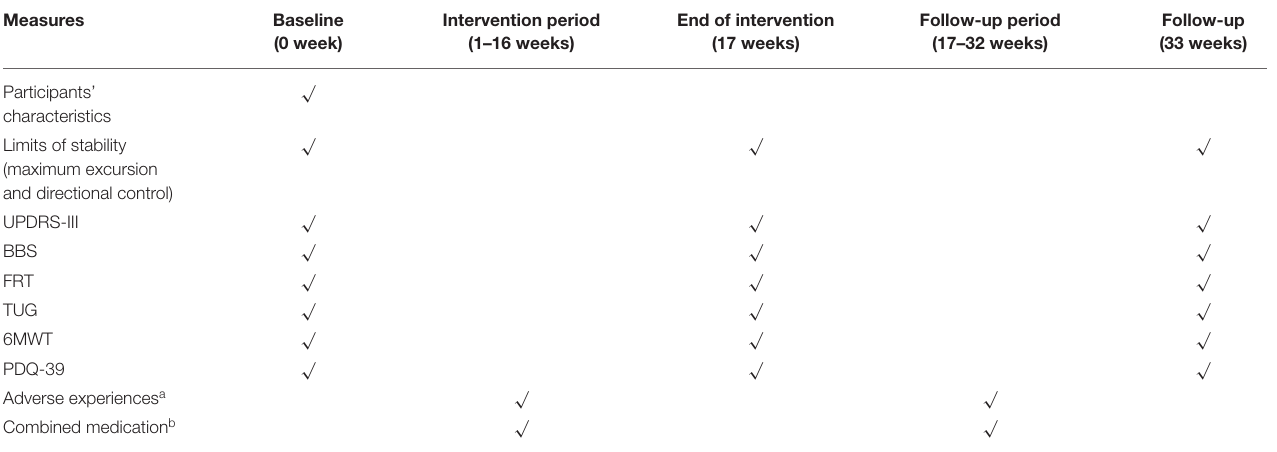
TABLE 1 | Schedule for data collection, the process of the assessments per visits.